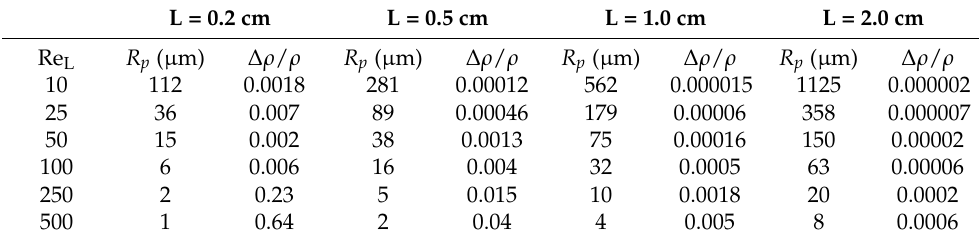
Table 2. Values about the Reynolds numbers of the background BL flow, particle’s parameters for the entrapped entities: small– R p < L / Re 5/4 chosen, namely, L = 0.2, 0.5, and 1